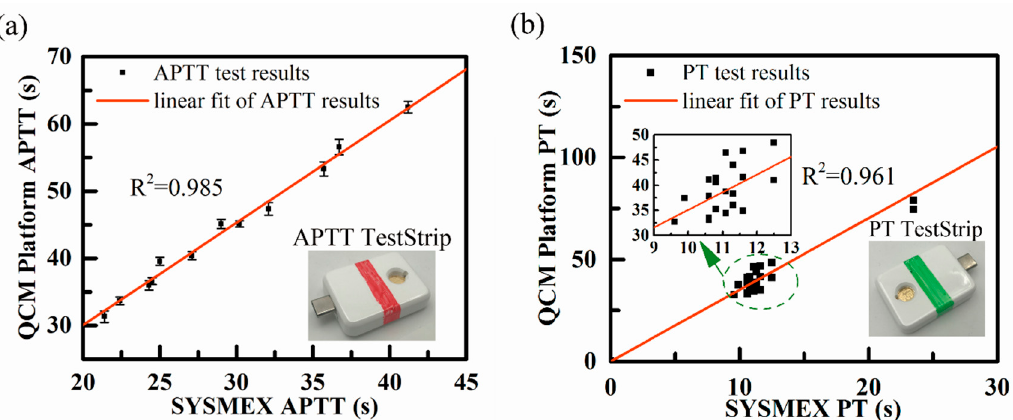
Figure 8. QCM coagulation testing platform results. ( a ) Comparison of twelve APTT measurements between the testing platform and CS-5100 hemostasis system. ( b ) Comparison of PT measurements between the testing platform and CS-5100 hemostasis system.